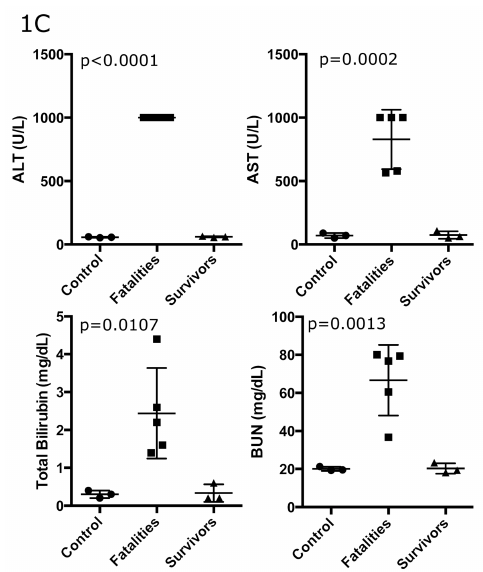
Figure 1. Clinical outcome of Pirital virus (PIRV) infection of Syrian hamsters. ( A ) Seven of the 10 hamsters died by day 12, whereas the remaining 3 infected hamsters appeared healthy until the conclusion of the experiment on day 20. ( B ) Complete blood counts of hamsters showed elevated white blood counts, hematocrit (HCT), hemoglobin (HGB) and mean platelet volume (MVP), and elevated platelet counts. ( C ) Alanine aminotransferase (ALT), aspartate aminotransferase (AST), bilirubin and blood urea nitrogen (BUN) levels were elevated in diseased hamsters but not in infected hamsters that did not show clinical signs of disease.